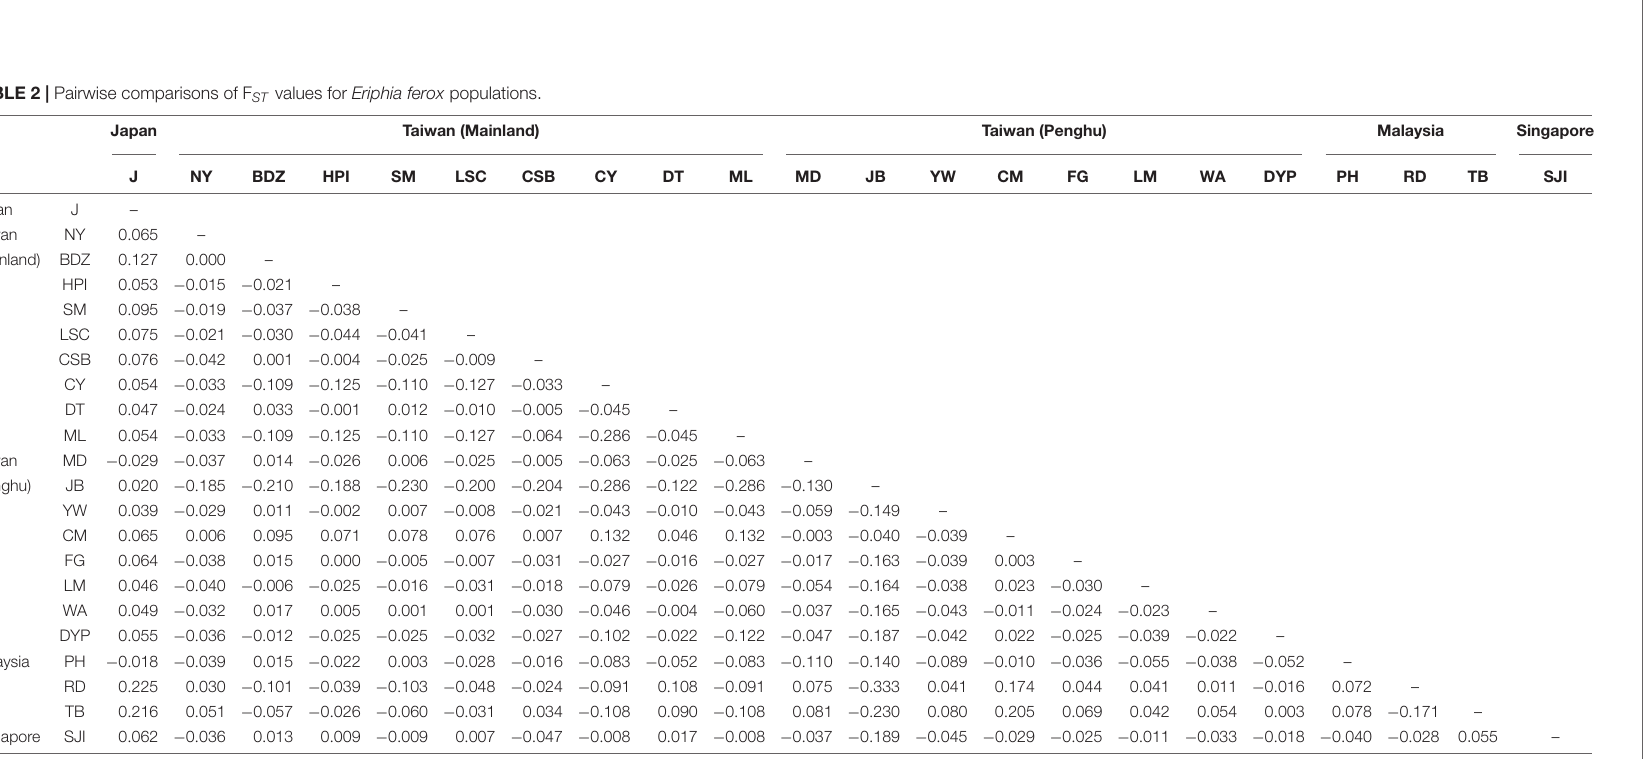
Site abbreviations are listed in Table 1